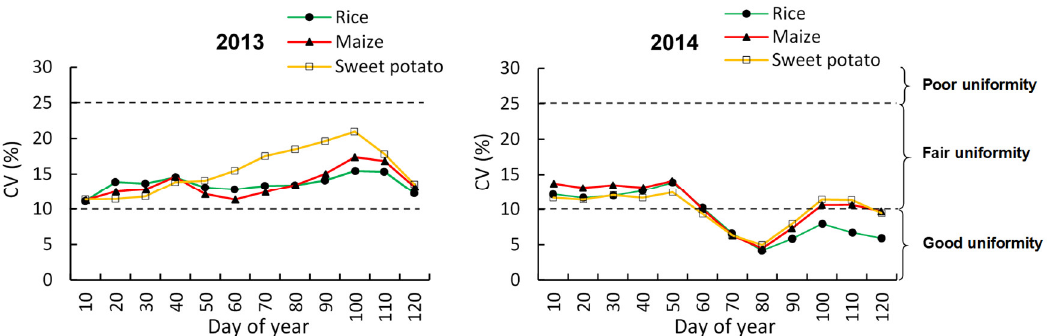
Figure 11. Variations of the uniformity of water consumption for paddy rice, maize, and sweet potato during January-April 2013 and 2014. The coefficient of variations (CV) of ET a was used to characterize the uniformity of water consumption. Dashed lines represent the thresholds for distinguishing between irrigated areas with poor, fair, or good uniformity of water consumption.